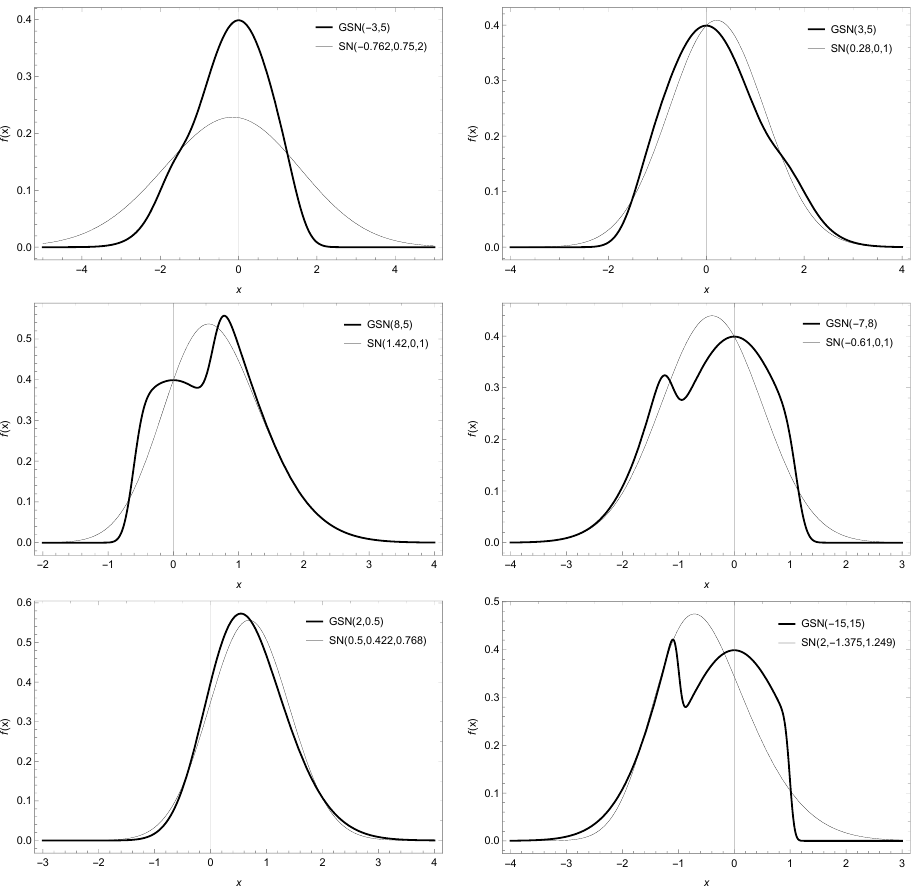
Figure 2. Plot of the pdf in (10) for selected values of parameters and comparison with the skew normal